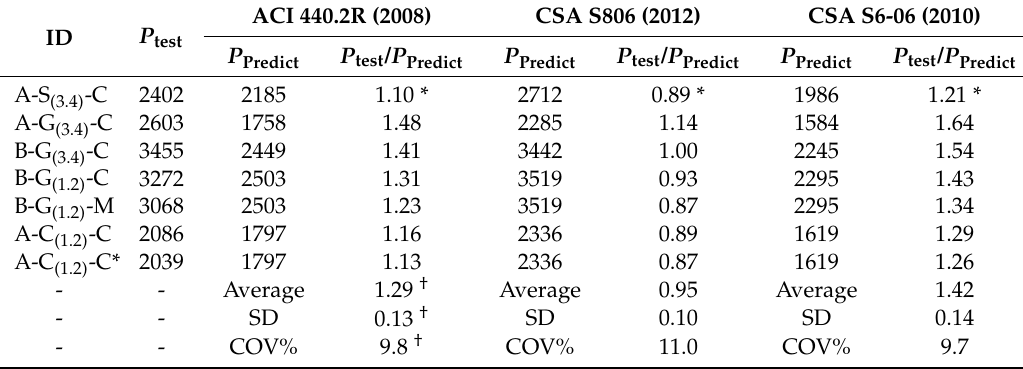
Table 7. Code predications comparisons versus test results for CFFT-reinforced columns (with no consideration for allowable confinement codes